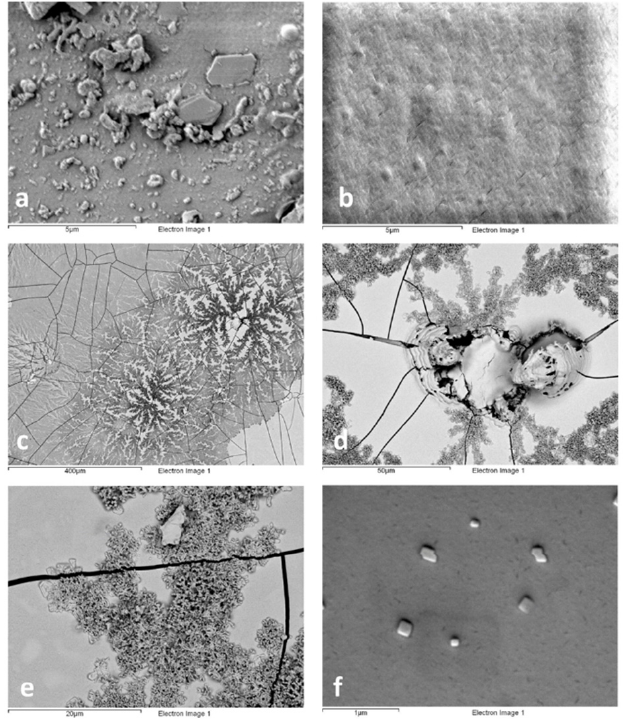
Figure 2. Backscattered electron (BSE) imaging for: ( a ) PB72 film before ageing; ( b ) PB72 film after 24-h exposure; ( c – e ) PB72 + PARNASOS after 24-h exposure; ( f ) TiO 2 on PB72 + PARNASOS after 24-h exposure.